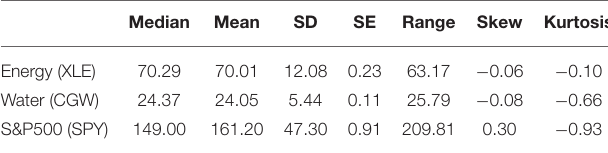
TABLE 1 | Descriptive statistics of the ETF’s: CGW, XLE, and